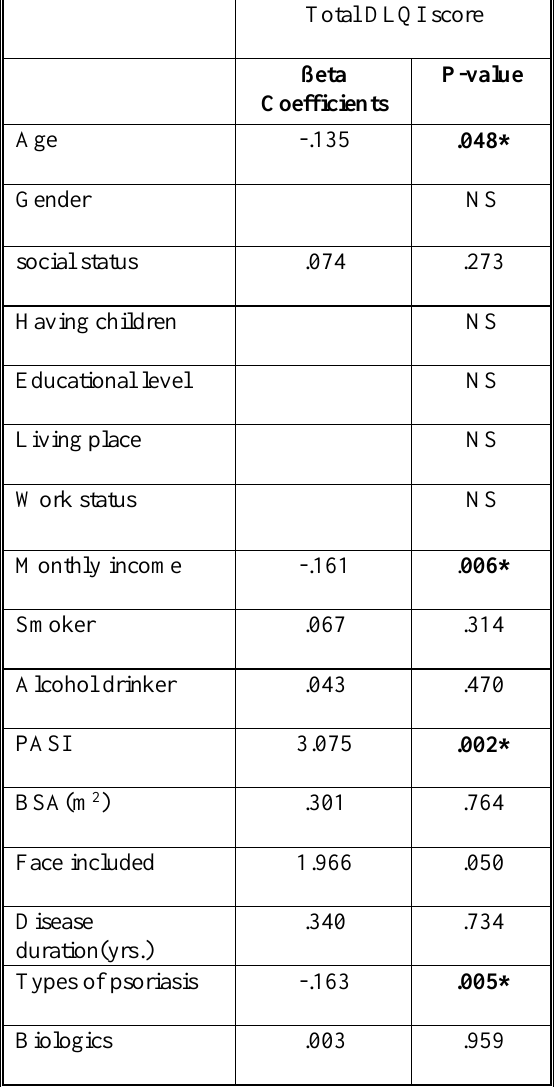
Table 6. Association of total DLQI score with socio-demographic and disease characteristics variables of the